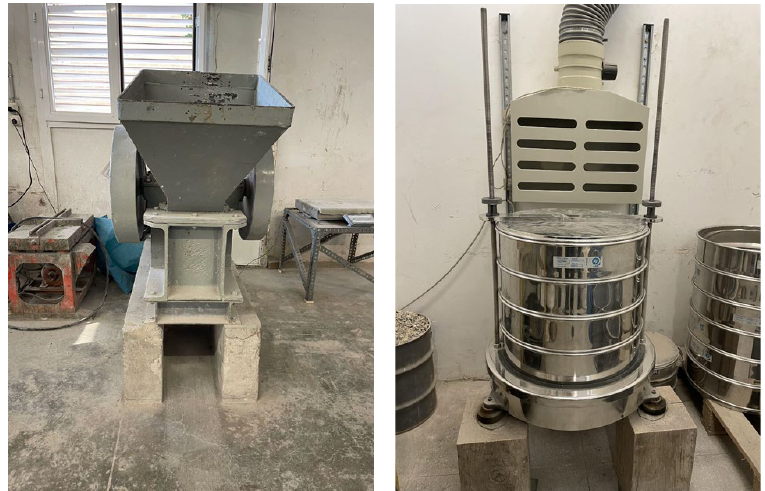
Figure 5. Relative machine: jaw crusher ( left ); sieve shaker ( right ).